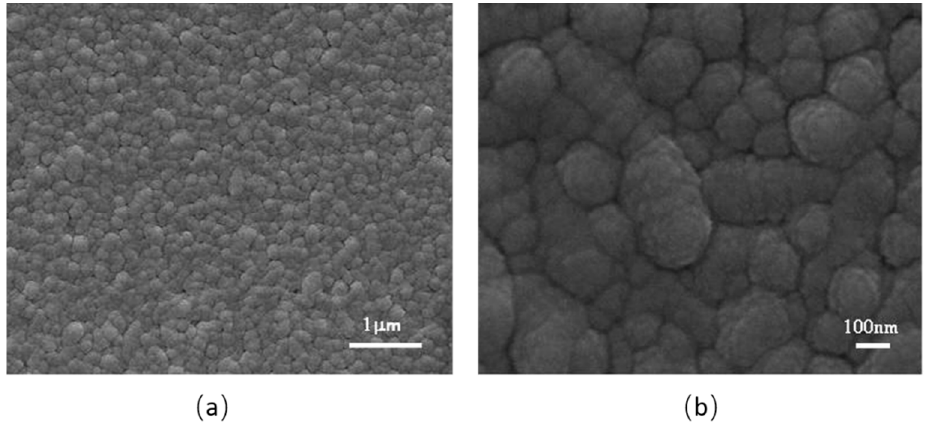
Figure 1. The SEM images of the sample of TTO2: ( a ) is the image for TTO2 films, and ( b ) is for the nanoparticles which form the film.